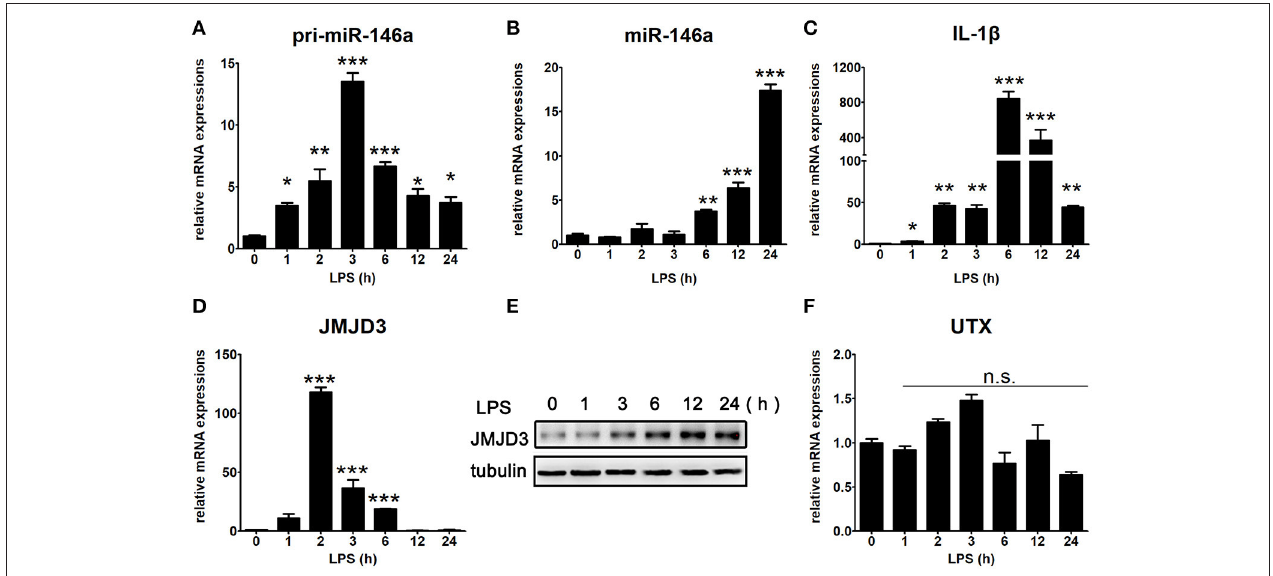
FIGURE 3 | Time specific expression pattern of inflammatory factors under LPS stimulation in macrophages. Raw264.7 cells were treated with LPS (100ng/mL). The mRNA expression levels of pri-miR-146a (A) , miR-146a (B) , IL-1 β (C) , JMJD3 (D) , and UTX (F) in Raw264.7 were determined by quantitative PCR. (E) The protein expression level of JMJD3 was determined by Western blotting. Data are shown as mean ± SEM ( n = 3). * P < 0.05; ** P < 0.01; *** P < 0.001.